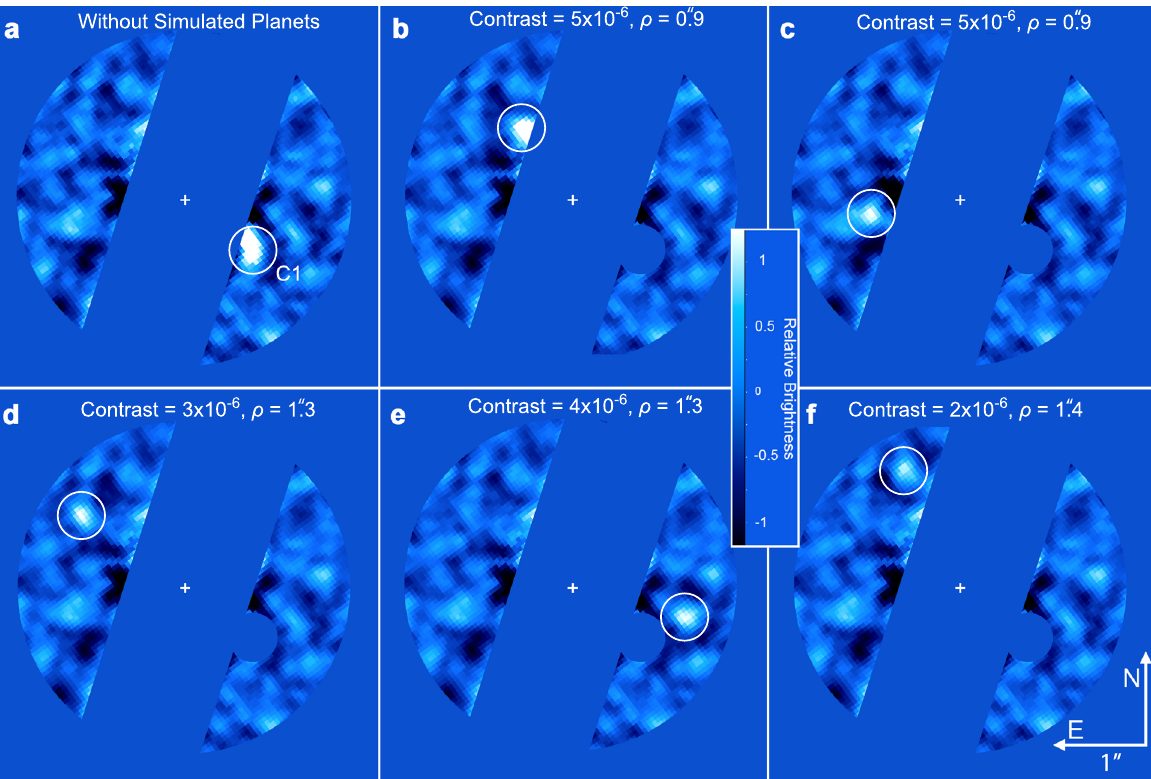
Fig. 3 Simulated planet injections. NEAR campaign image ( a ) and those with simulated planets ( b – f ). Each image has been PSF-subtracted following removal of known artifacts. The location of C1 has been masked in ( b – f ) so that the simulated planets (indicated in these panels by white circles) can be clearly identi fi ed. These examples demonstrate the lower brightness limit at which simulated planets are identi fi able. The bottom right panel represents the limiting case at which the source is marginally identi fi able among speckles of similar brightness.